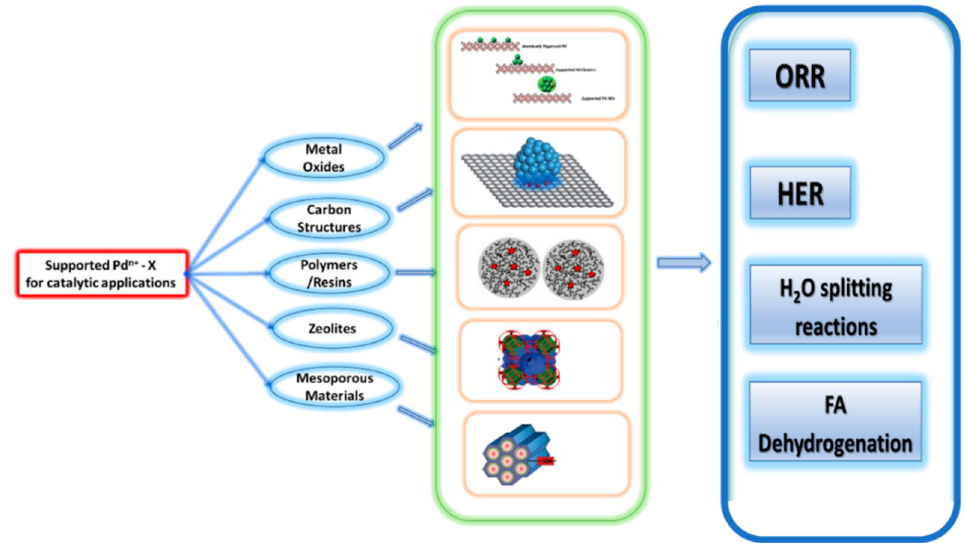
Figure 2. Supported Pd species on different matrixes and possible catalytic applications.